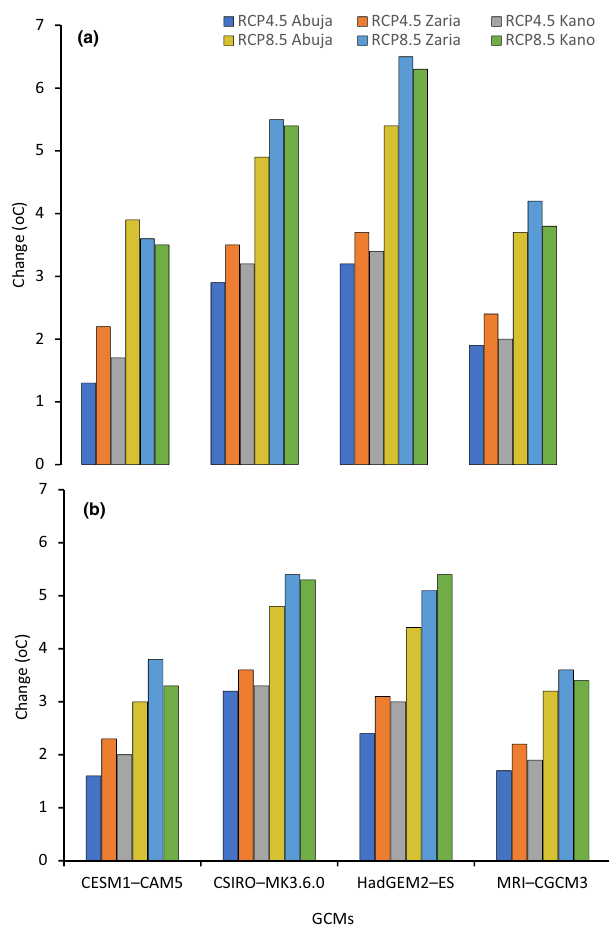
Figure 5. Minimum ( a ) and maximum ( b ) temperature change from the baseline period for four GCMs under RCP4.5 and RCP8.5 at Abuja, Zaria and Kano in Nigeria for end-of-century period.